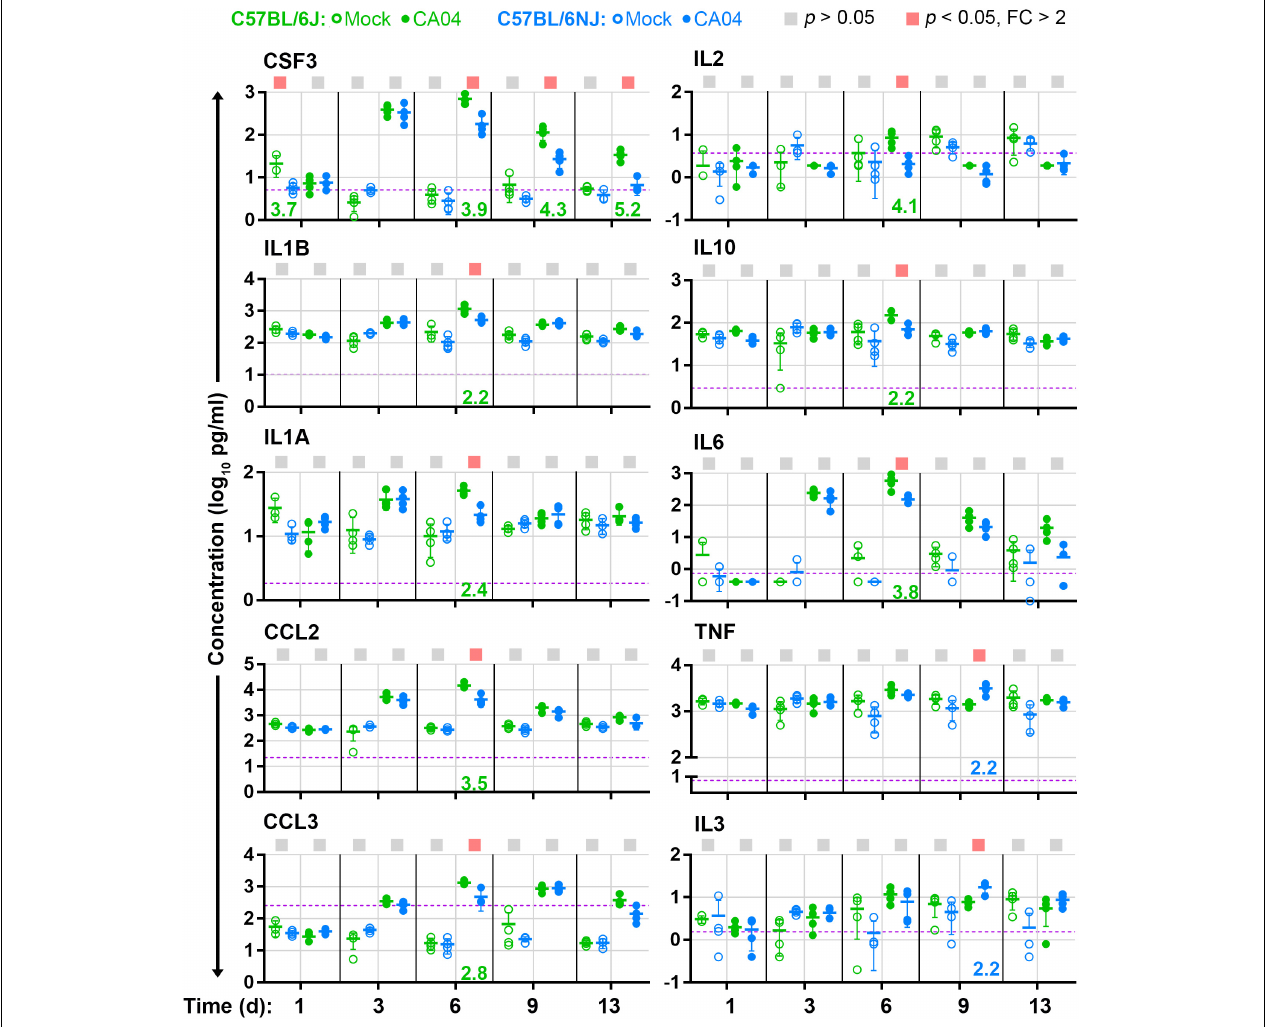
FIGURE 5 | Lung cytokine levels. For cytokines that are differentially expressed (fold change [FC] > 2, Holm–Sidak-adjusted p < 0.05) in concentration between CA04-infected C57BL/6J and C57BL/6NJ mice in at least one time point, the concentrations [picograms (pg) per ml] in lung homogenates are shown for individual mock-infected and CA04-infected mice for all time points. Group means are shown by horizontal bars, error bars indicate standard deviation, and the limit of detection is represented by a dashed purple line. Colored squares at the top of each graph indicate statistically significant differences between C57BL/6J and C57BL/6NJ for a given comparison. Fold-changes associated with statistically significant comparisons are indicated at the bottom of each graph (green text indicates higher expression in C57BL/6J mice, and blue text indicates higher expression in C57BL/6NJ mice). See Supplementary Table S2 for all cytokine